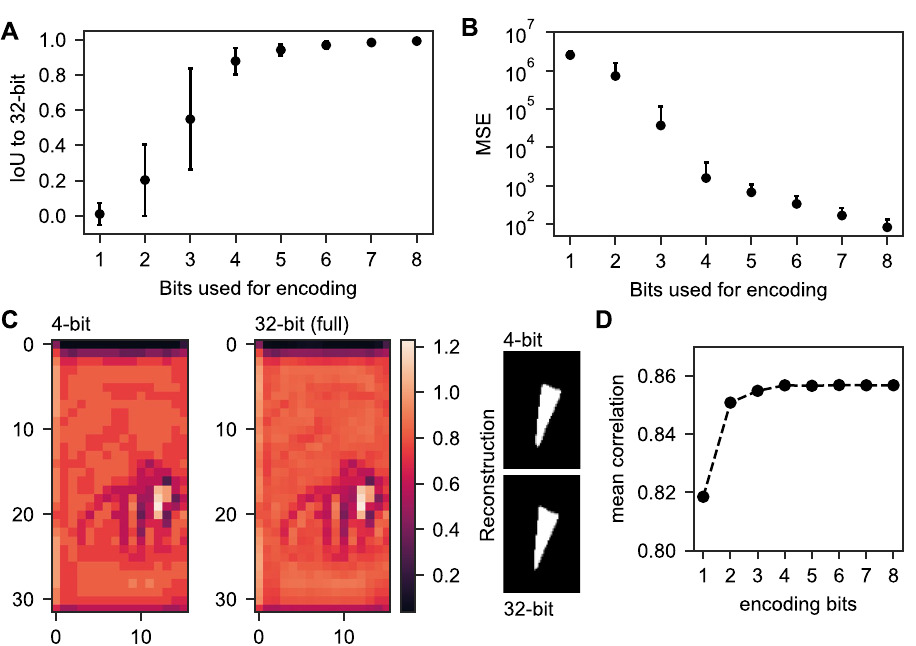
Figure 4. Four bits were sufficient for accurate reconstruction. ( A ) IoU score comparing the reconstructions from lower bit encodings to the full 32-bit reconstruction. ( B ) Mean squared error (MSE) for lower bit reconstruction and full 32-bit reconstruction. ( C ) Example for 4-bit and respective 32-bit encoding with respective reconstruction. ( D ) Mean correlation of low bit latent space image (cid:31) 1 and glottal area waveform